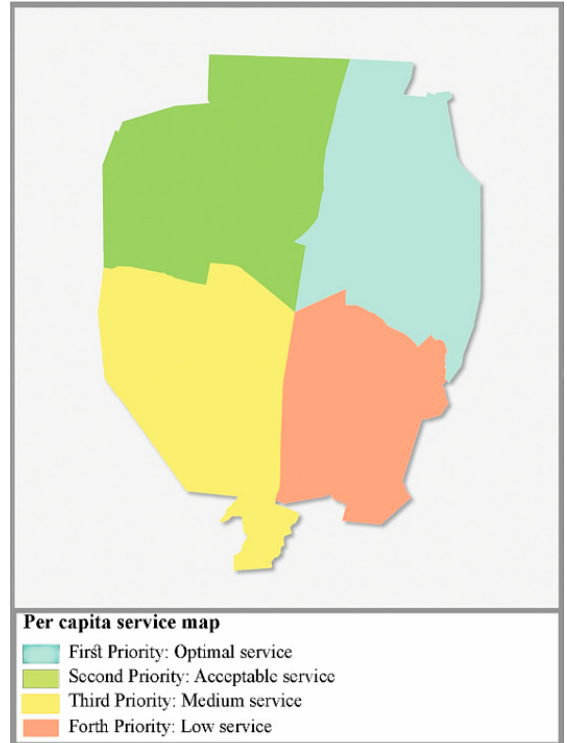
Figure 18. The per capta service map of Hamedan based on the sub-criteria measures in Table 1.